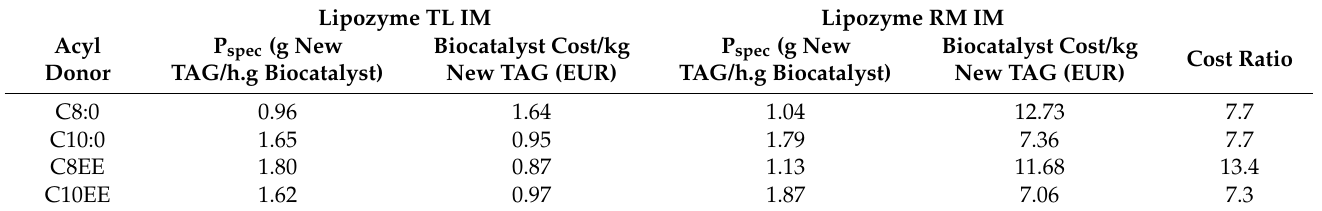
Table 3. Specific productivities of New TAGs (P spec ) obtained in each system, and respective biocatalyst